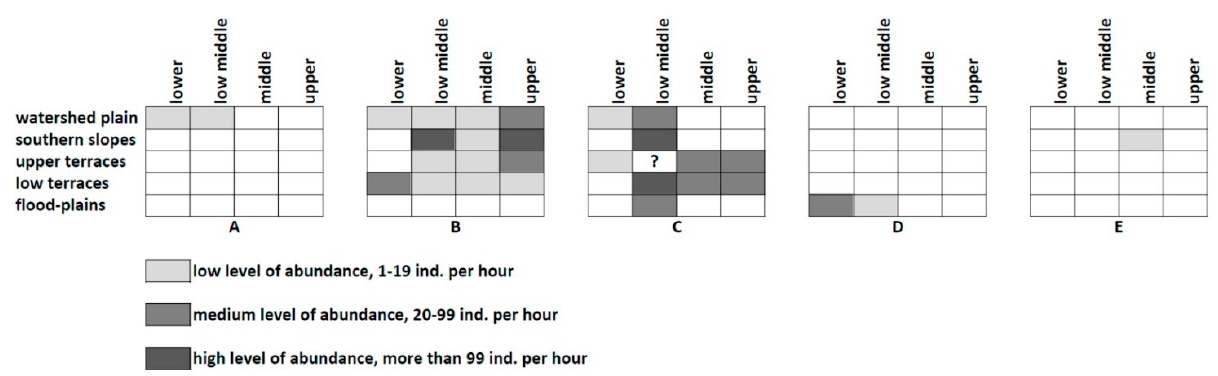
Figure 4. Population distribution of model orthopteran species across the basin of the small Zyrianka River (forest-steppes of SE West-Siberian Plain, SE Novosibirsk). ( A )— Psophus stridulus (Linnaeus); ( B )— Chorthippus apricarius (Linnaeus); ( C )— Chorthippus parallelus (Zetterstedt); ( D )— Chorthippus montanus (Charpentier); ( E )— Dociostaurus brevicollis (Evers- mann).